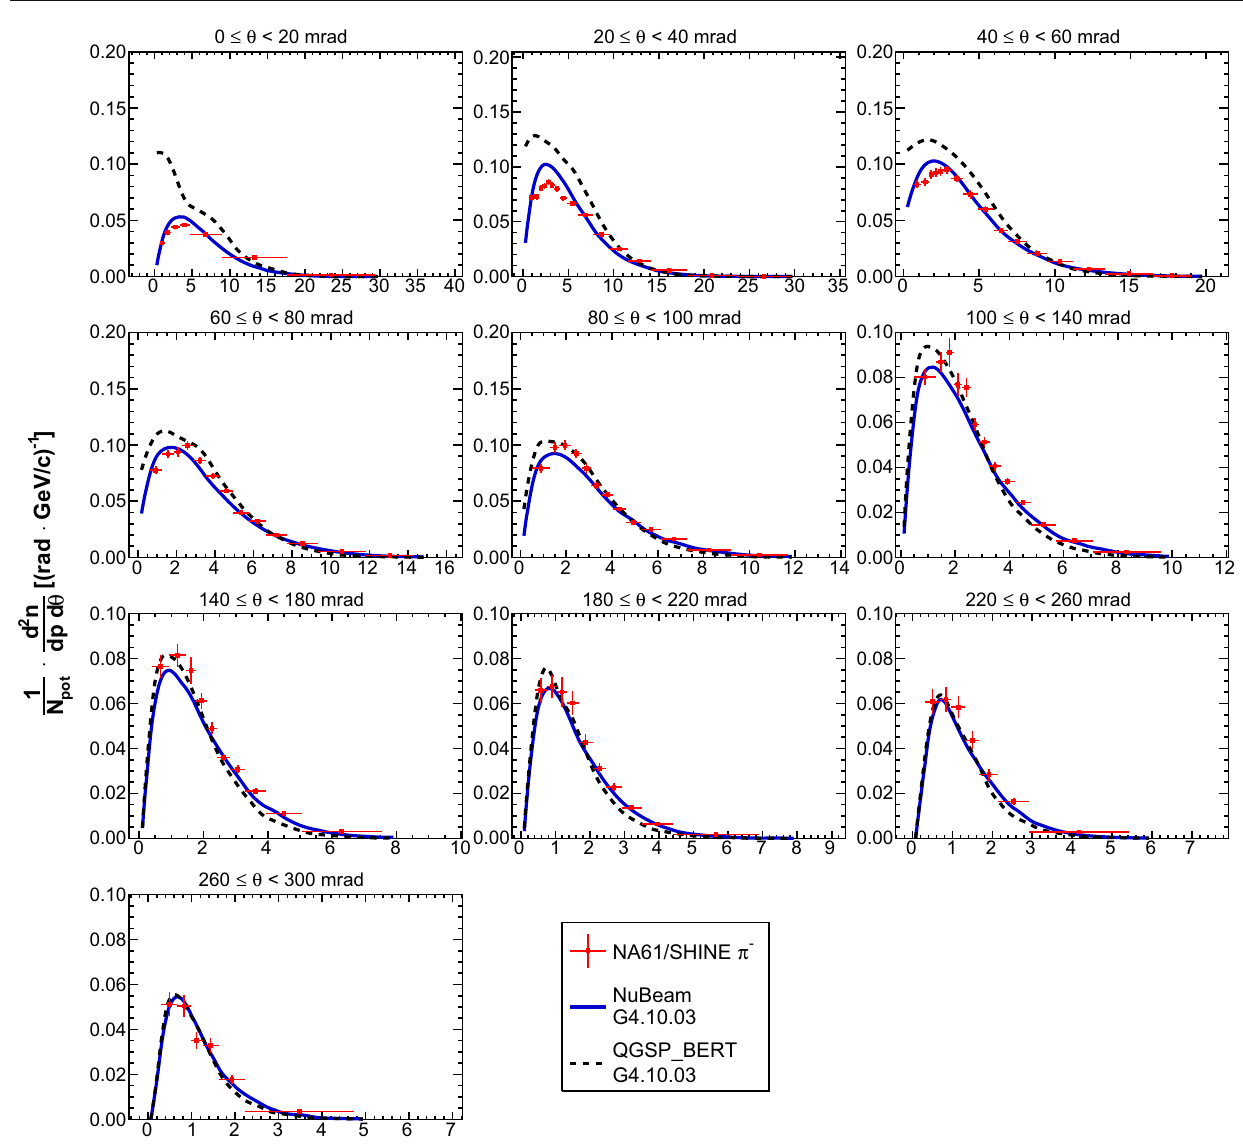
QGSP_BERT (dashed black line) physics lists from Geant4.10 .03 [27,28] are overlaid on top of the